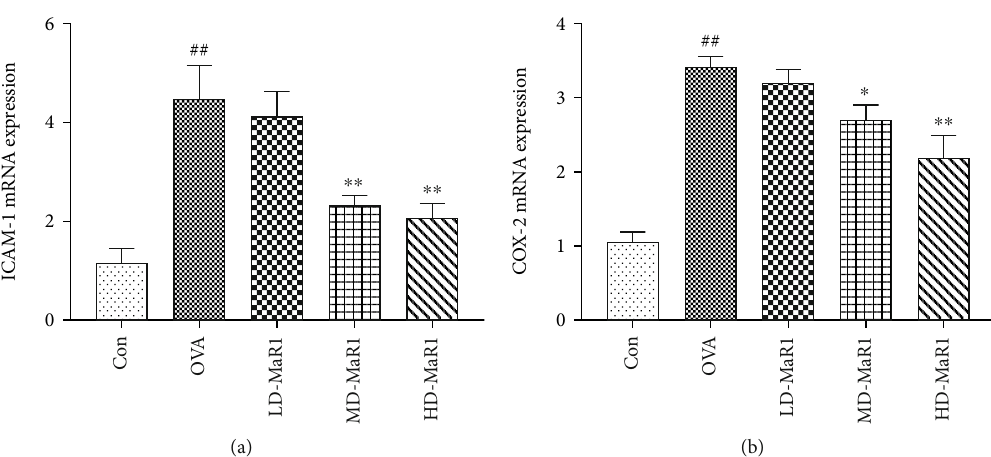
Figure 7: qRT-PCR assays were used to detect the expression levels of NF- κ B downstream in fl ammatory genes, such as ICAM-1 and COX-2. (a) The mRNA expression levels of ICAM-1. (b) The mRNA expression levels of COX-2. Data expressed as mean ± SEM ( n = 6/group ). ## P < 0 : 01 , # P < 0 : 05 vs. the control group; ∗ P < 0 : 05 , ∗∗ P < 0 : 01 vs.